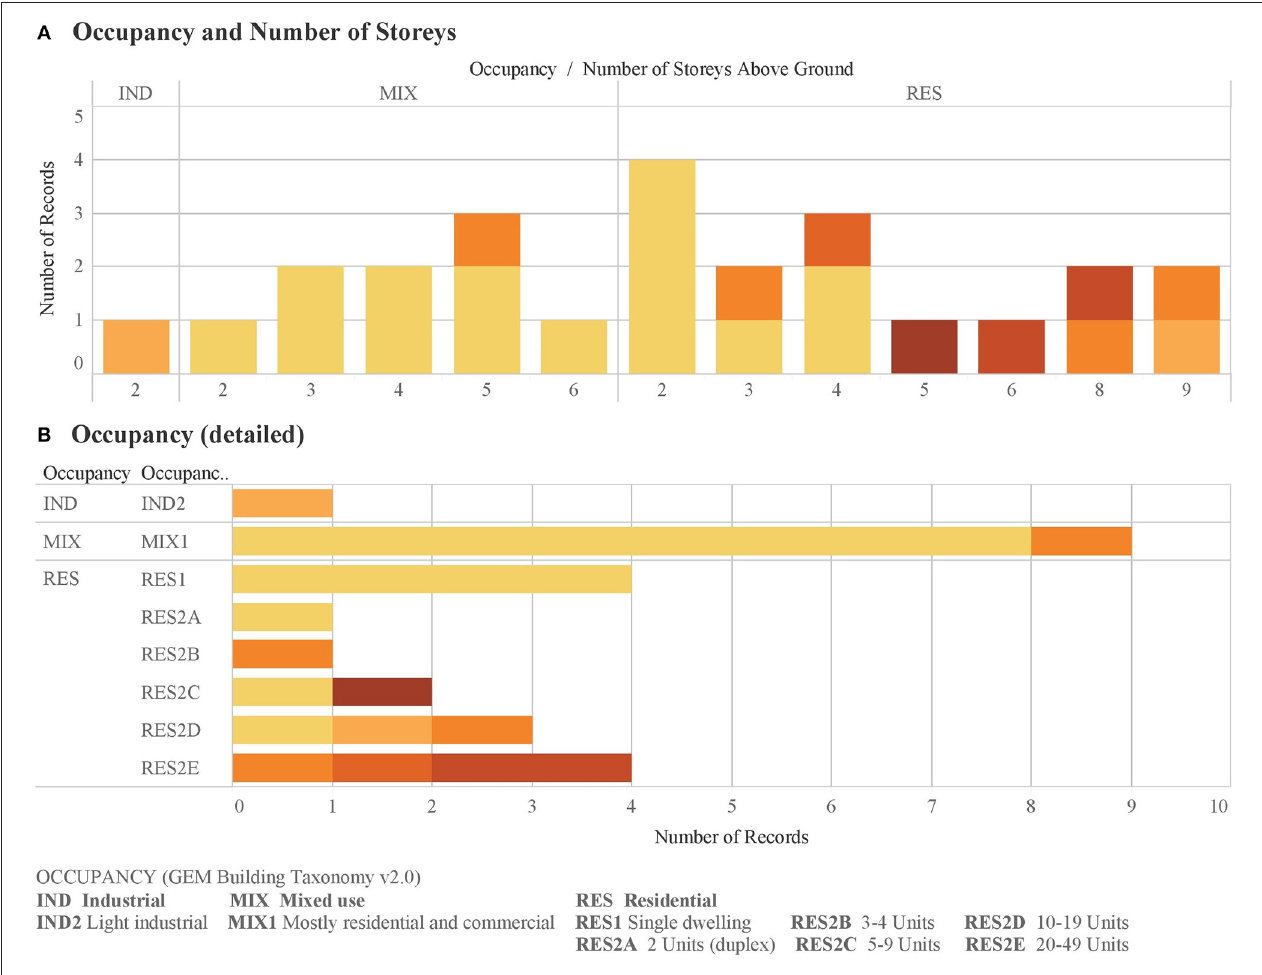
FIGURE 6 | (A) Building categorized by occupancy and number of story. (B) Detail of the building occupancy.